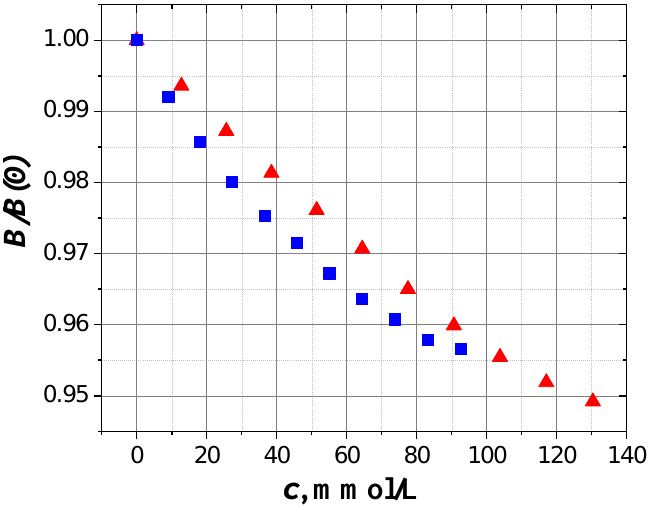
Figure 3. The concentration dependence of the normalized Froehlich function B / B (0) for aqueous solutions of: AMP (red triangles) and ATP (blue squares) at 25 °C. Reprinted with permission from reference [10], (Copyright 2012, American Institute of Physics).